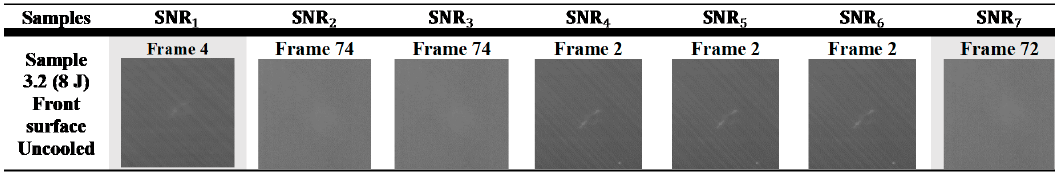
Figure 17. ( A ) Focused image of frame 480 of sample 3.2uncooledfront surface. The damage is visible in the noisy dataset which also contains some reflectance. ( B ) 3D pixel map of sample 3.2uncooledfront surface, frame 480. ( C ) Temperature/time graph from 3.2 front surface uncooled (red—defect area pixel; blue—sound area pixel).